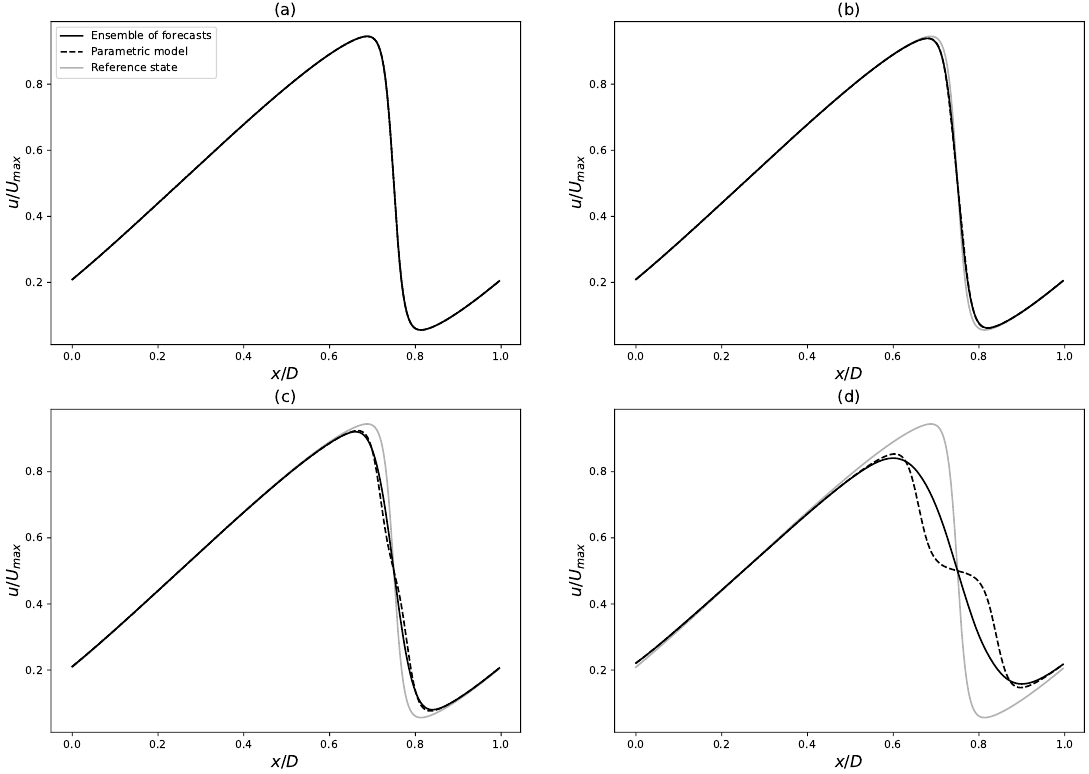
Figure 4. Mean state at time t = T computed from the ensemble of forecasts (solid line) and predicted from the parametric model (Eq. 29a, 29b, 29c) (dashed line), for the initial perturbations of magnitude (a) σ 0 solid